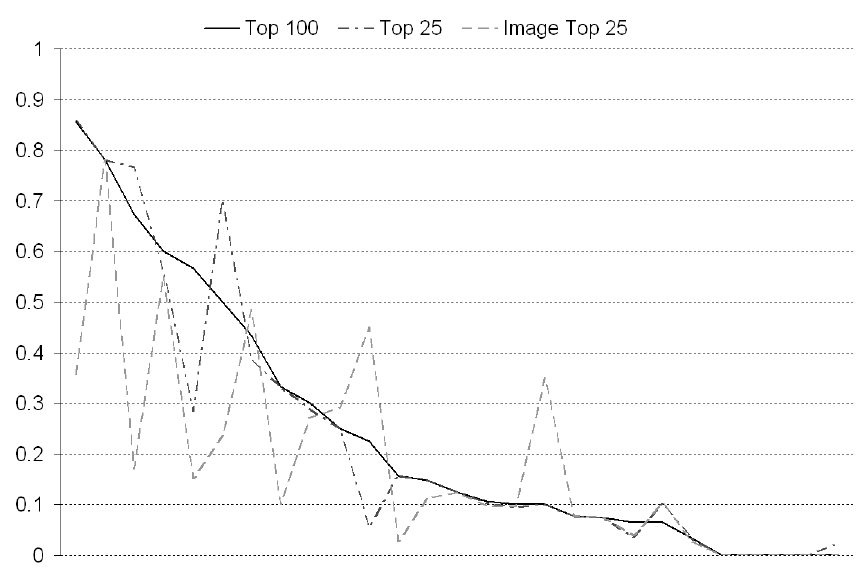
Figure 10. Selection of seed geotagged photos to extract tags—x axis is ordered from most to least successful query topic.